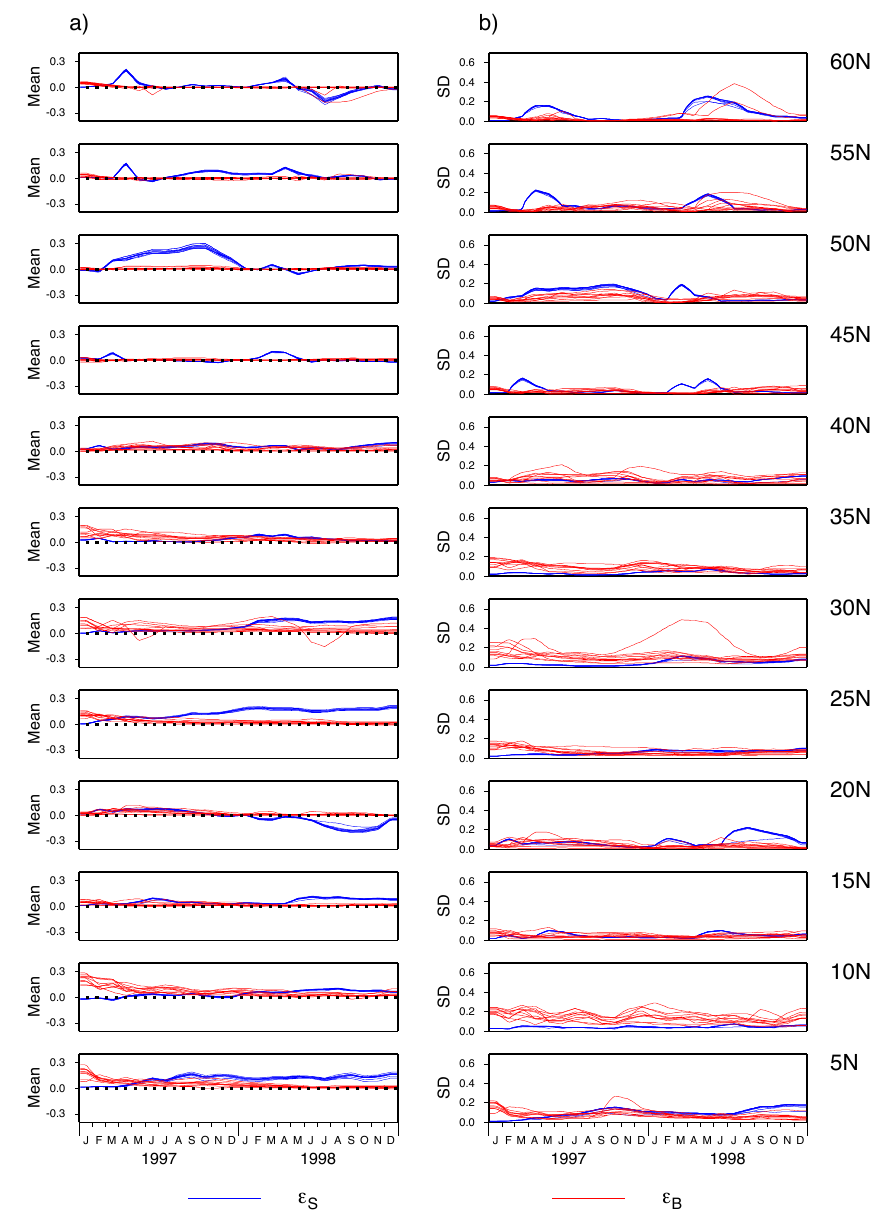
Figure B2. Predicted statistics for the mean environment simulation residual (cid:15) S and the parametric environment residual (cid:15) B for all 10 experiments: (a) residual means u S and u B ; (b) residual standard deviations s S and s B . Values are in log 10 (chlorophyll) units with chlorophyll in mgm − 3